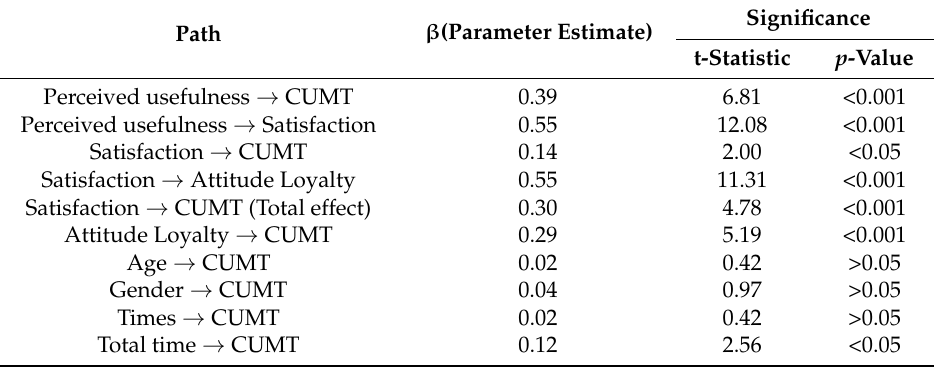
Figure 2. Base model of CUMT. Table 6. PLS results for the base mode.